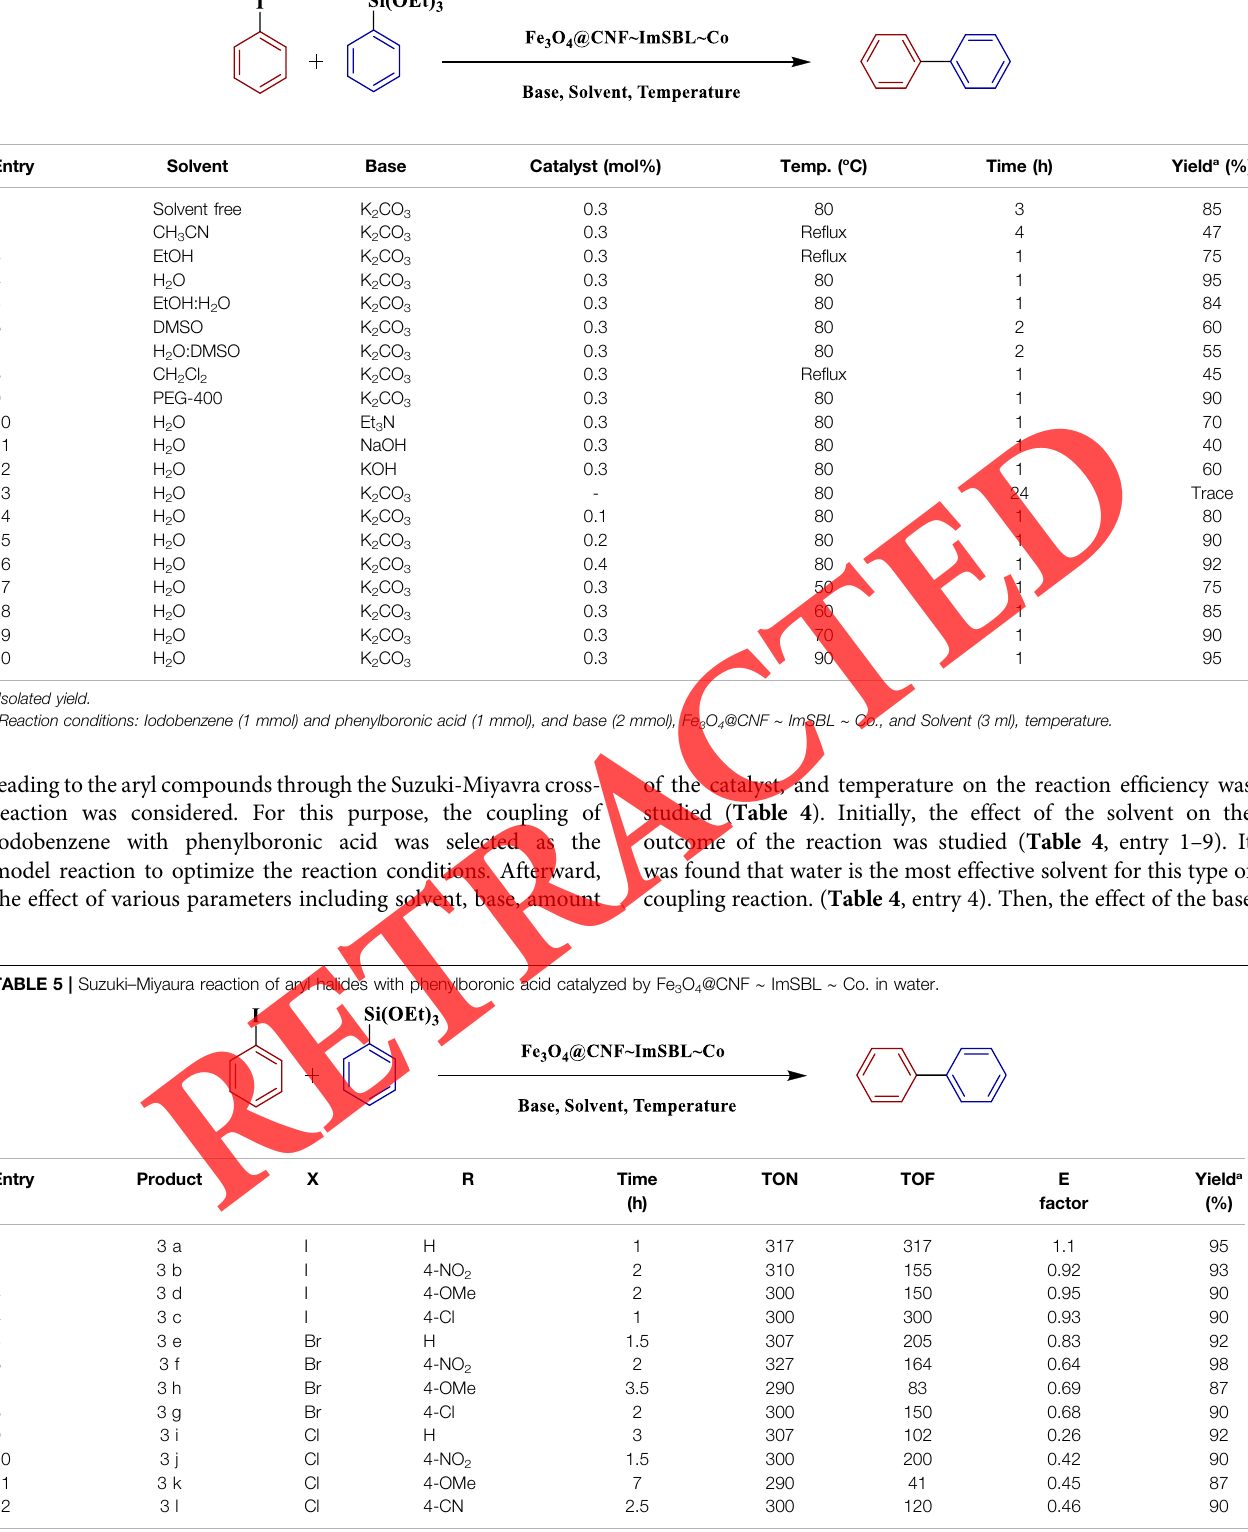
TABLE 4 | Optimization of the reaction conditions for the C-C cross coupling of iodobenzene with t phenylboronic acid.